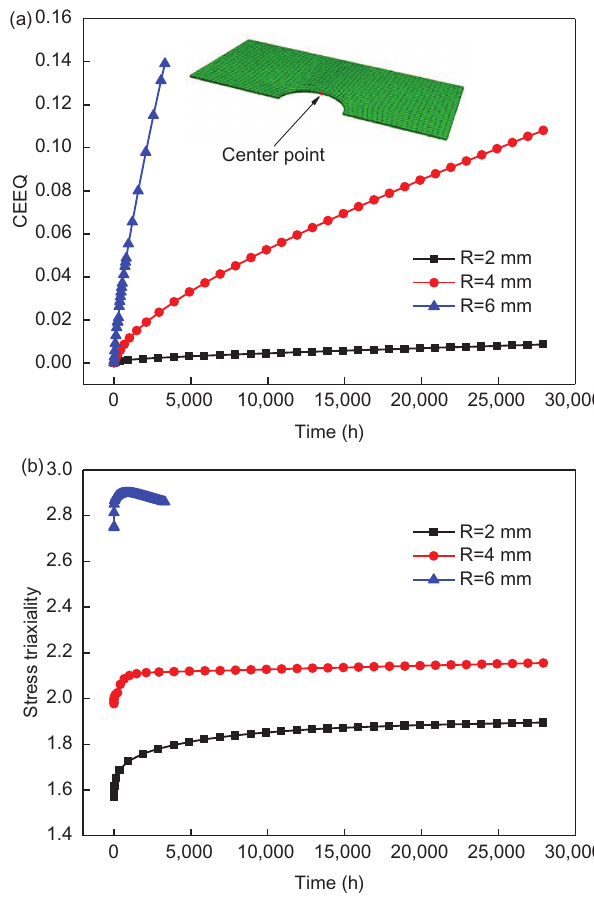
Figure 10: The CEEQ (a) and stress triaxiality (b) variation with time of center point for different defect